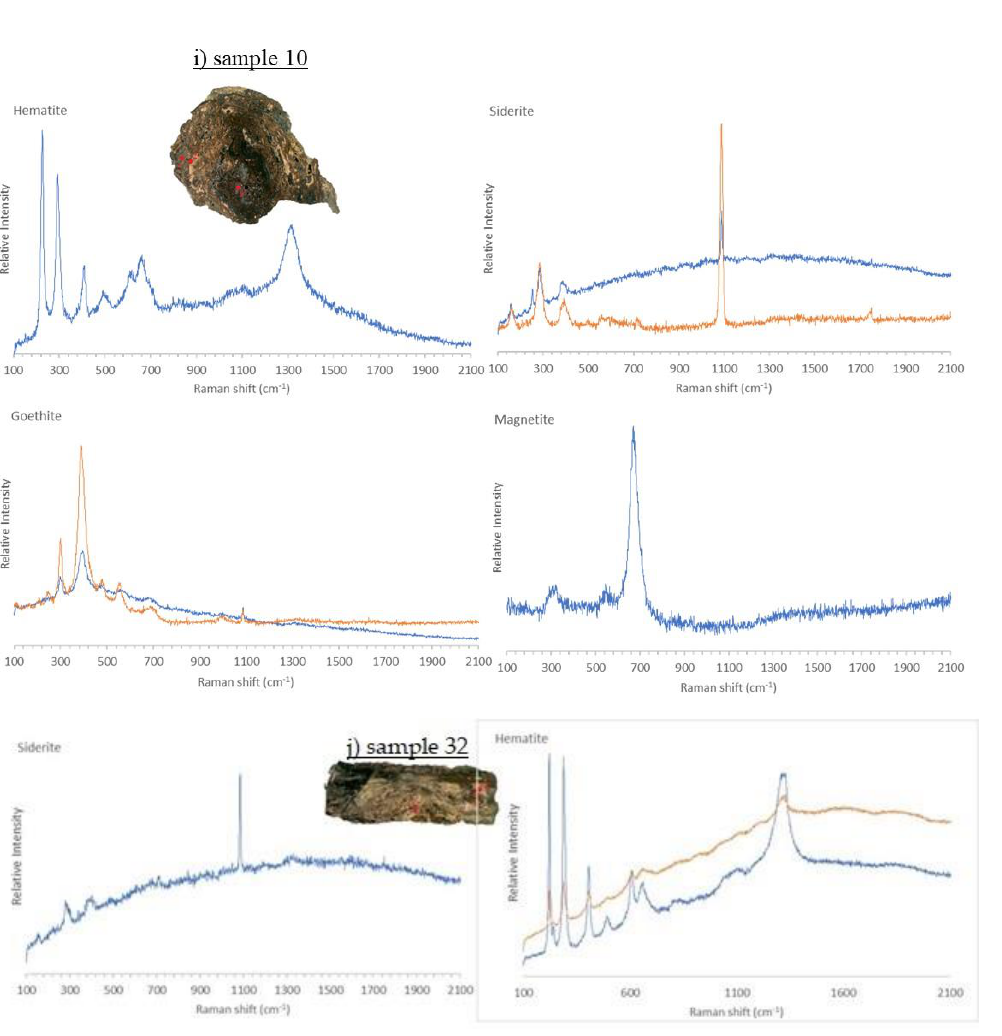
Figure 15. Micro-Raman observation and the relative spectra of all the iron ( a – e ) and copper ( f – j ) samples analyzed. The different colored spectra represent different analysis in the same point.